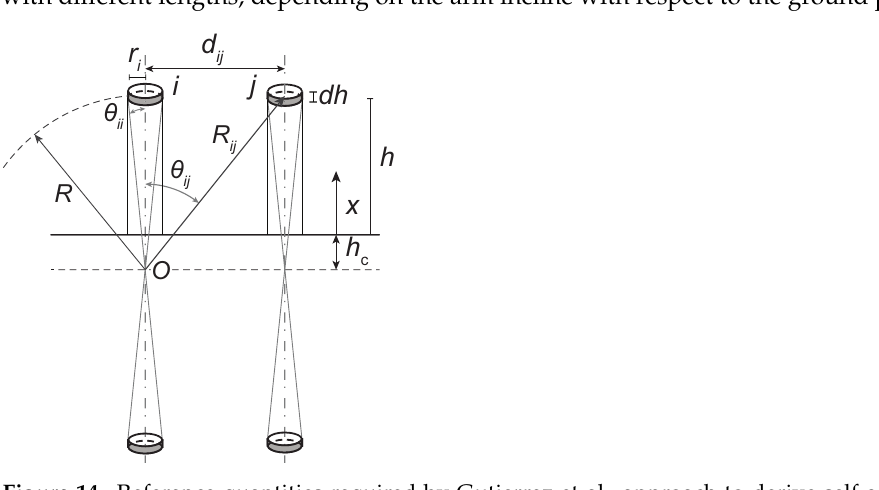
Figure 14. Reference quantities required by Gutierrez et al. approach to derive self and mutual characteristic impedances of the tower